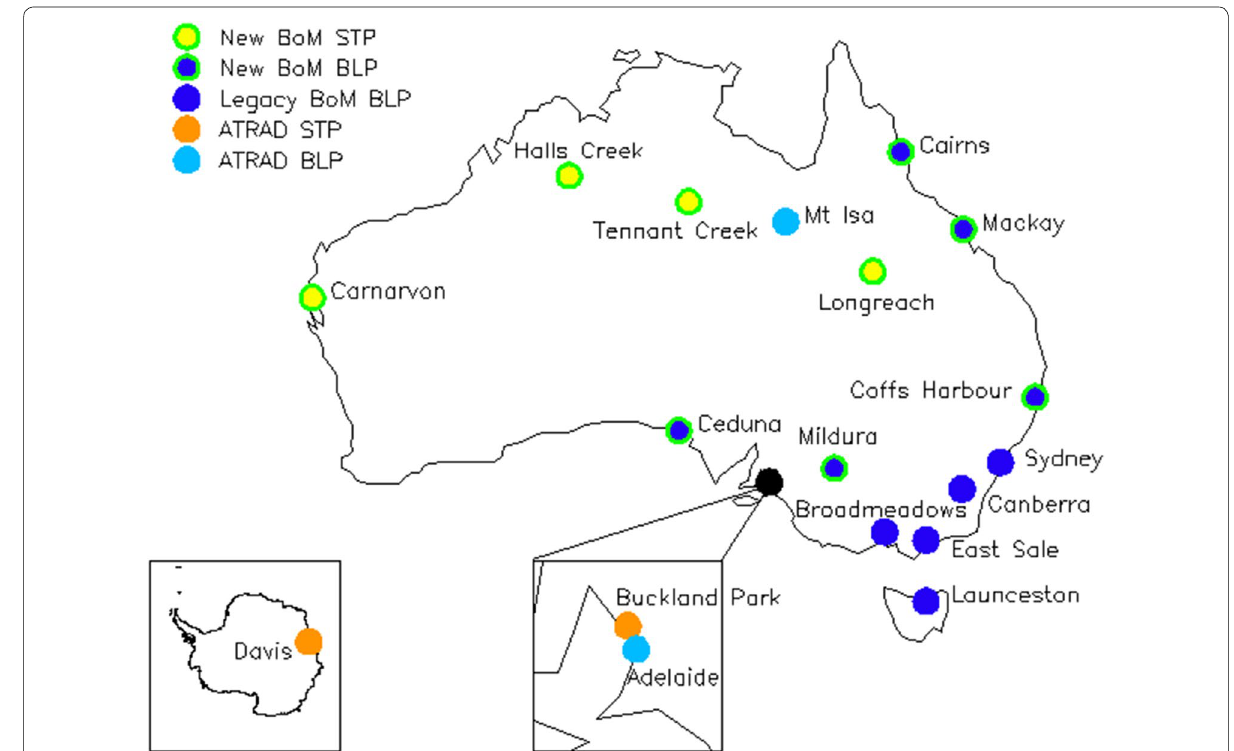
Fig. 1 The Australian Wind Profiler